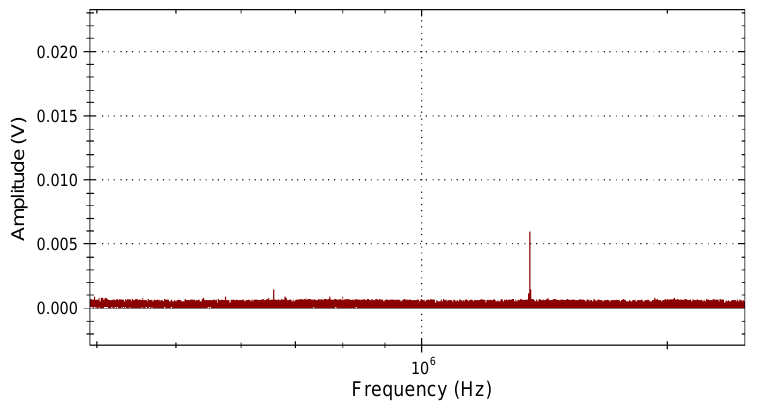
Figure 26. PD pulse at 1.5 MHz.